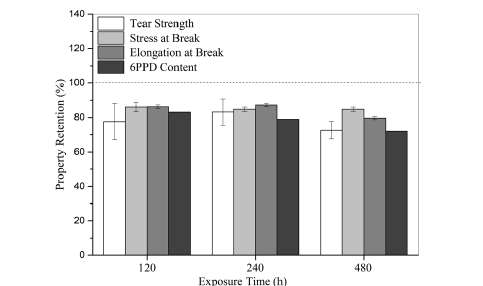
Figure 14. Retention of mechanical property in UV chamber photochemical aging of the compositions comprising 2.5 phr of 6PPD and 1.0 phr of TMQ.